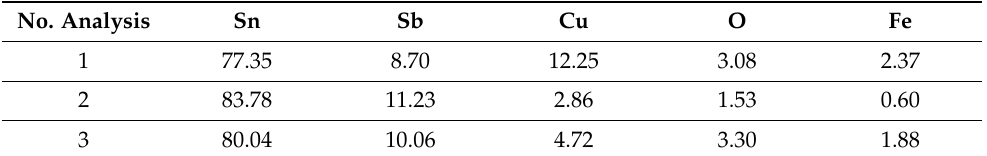
Table 7. EDX analysis of selected zones from Figure 4c of the wear surface of B83 babbitt at a load of 50 N, mass norm., %.